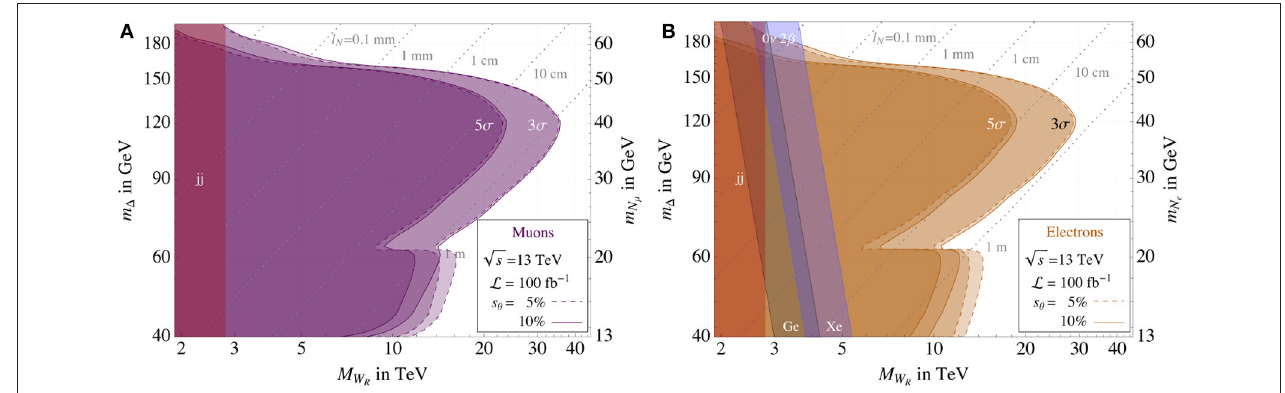
FIGURE 33 | (A,B) 13 TeV LHC sensitivity to the LRSM in the ( M N , M W